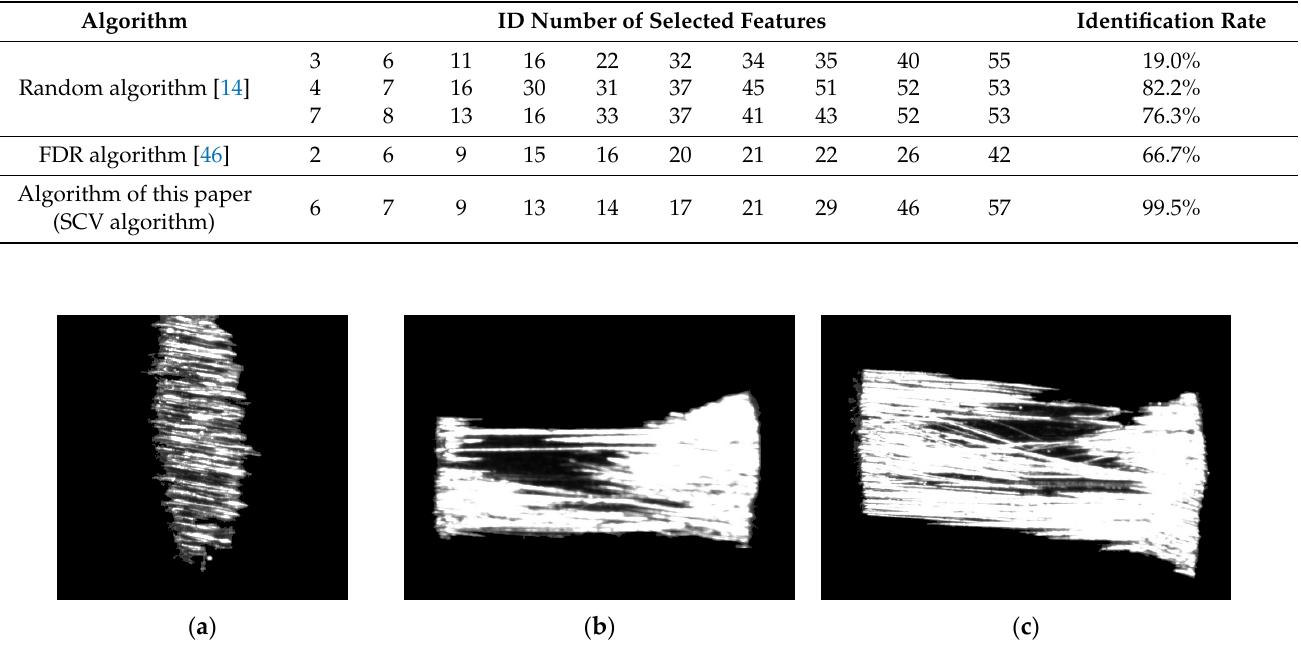
Figure 14. Misclassified sample: ( a ) scratch defect, #402; ( b ) scratch defect, #492; ( c ) scratch defect, #600. Table 3. Input and output values of the back-propagation neural network of some of the samples detected by the proposed algorithm.